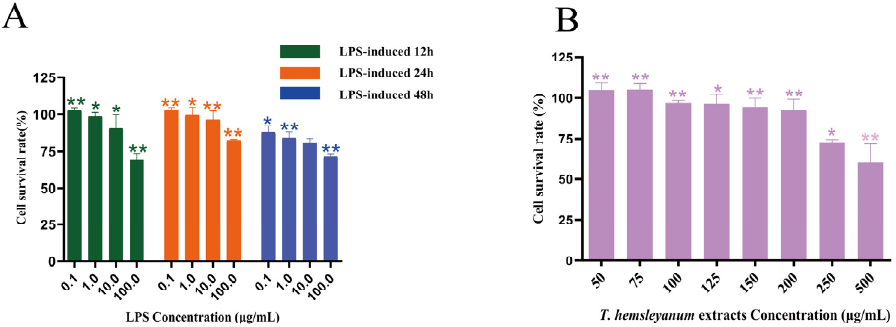
Figure 4. The cytotoxicity of T. hemsleyanum and LPS on RAW264.7 cells. Cytotoxicity of T. hemsleyanum extracts on RAW264.7 macrophages ( A ), * p < 0.05, ** p < 0.01; cytotoxicity of LPS on RAW264.7 macrophages ( B ), * p < 0.05, ** p < 0.01.